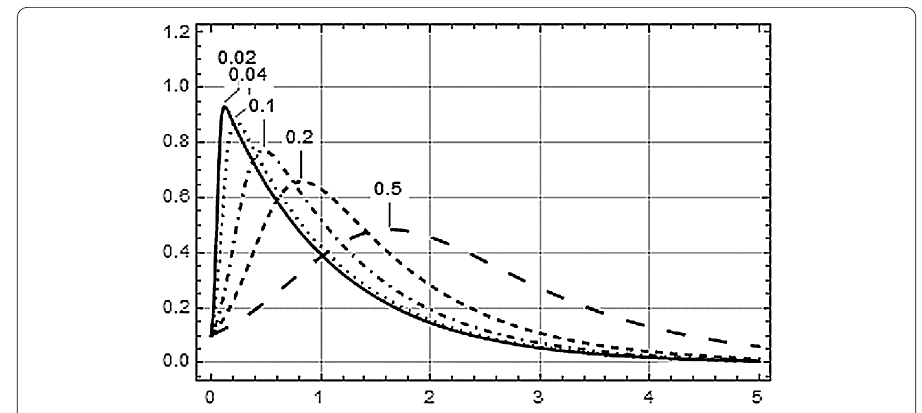
Figure 1 Fractional Volterra population graph obtained by FTM for β = 1.